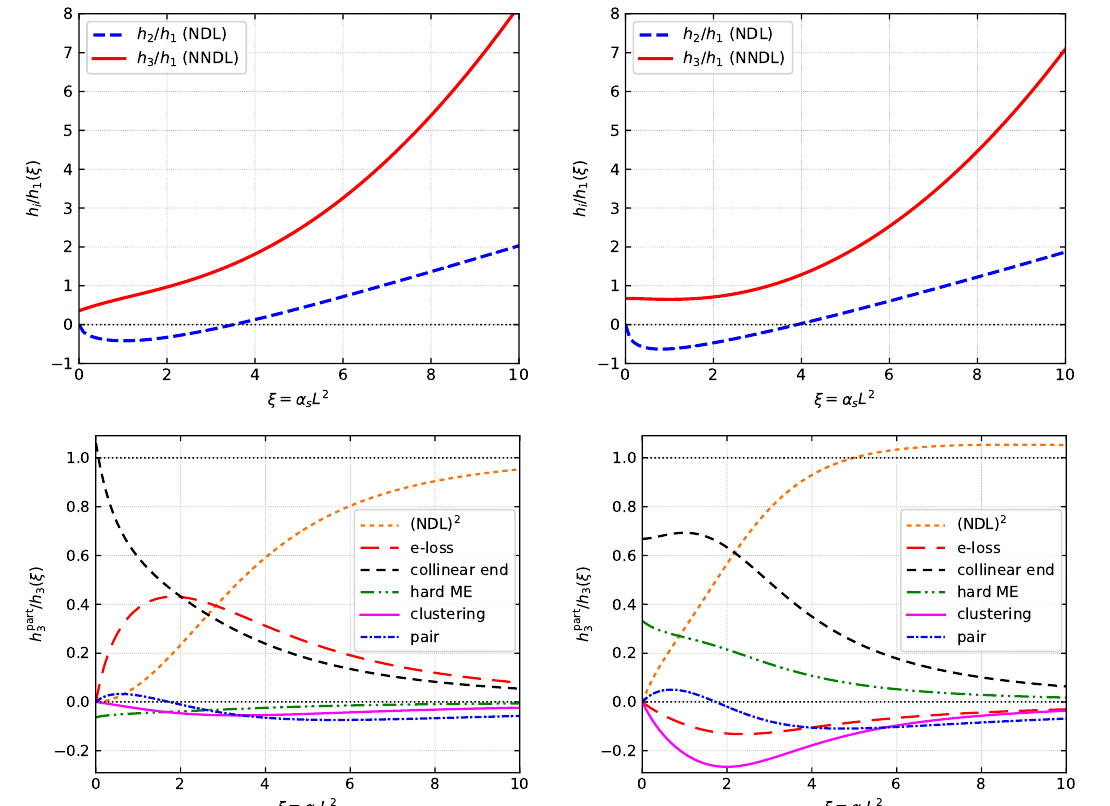
Figure 6. Top: ratio of NDL (blue) and NNDL (red) resummation functions to the DL result as a function of α 2 for quark (left) and gluon hemispheres (right). Bottom: relative weight of the s L NNDL contributions to h for quark (left) and gluon hemispheres 3